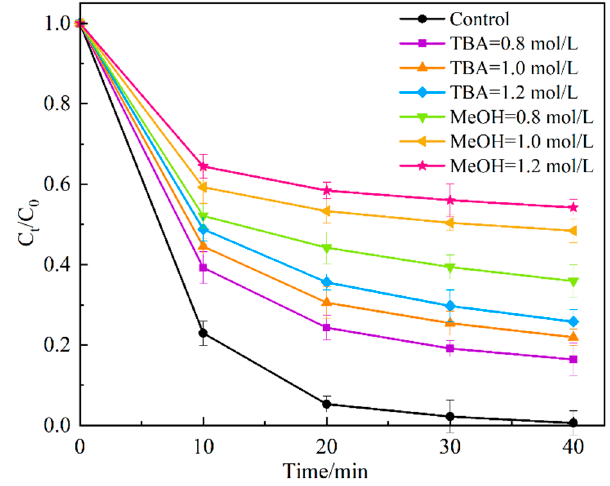
Figure 11. Effect of the quencher on the degradation of MO.